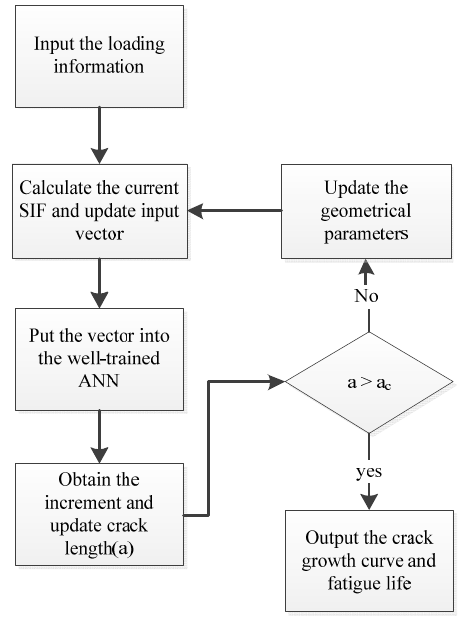
Figure 5. The flow chart of the ANN-based algorithm.